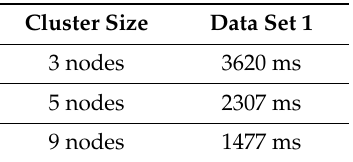
Table 3. Analysis of query performances according to the cluster